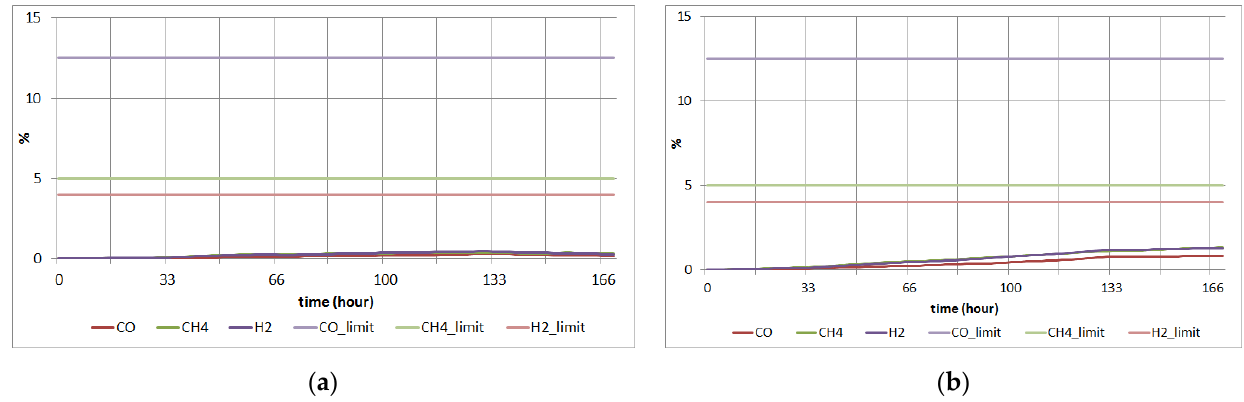
Figure 6. The simulation results of potential explosion at gas leak for the experiment #3 ( a ) volume flow of fresh 25m 3 /h ( b ) volume flow of fresh 1m 3 /h.